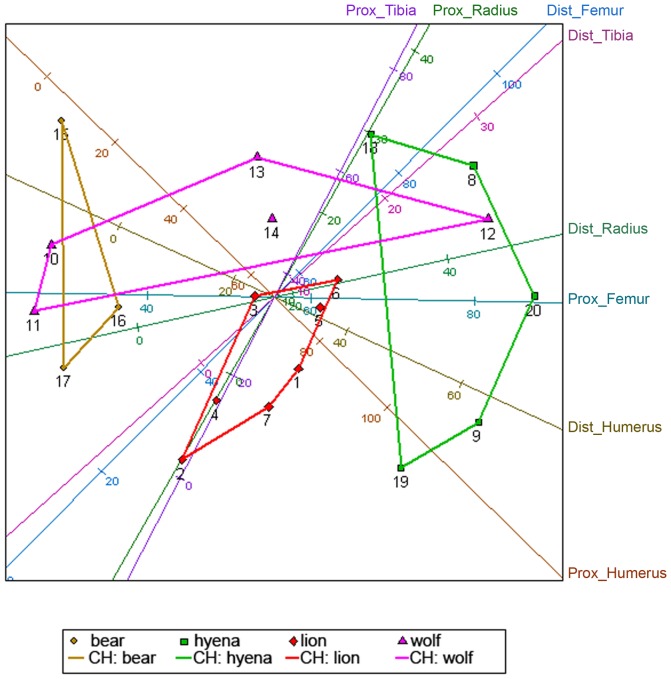
MDS plot showing a two-dimensional solution for four carnivore species and ungulate long limb bones.